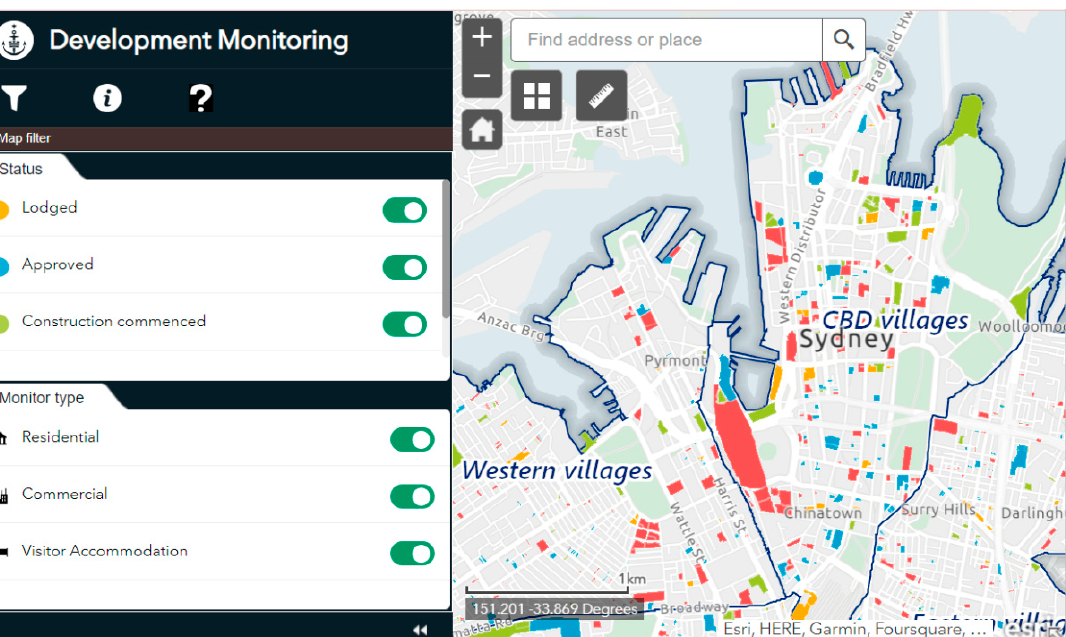
Figure 5. Snapshot of Development Monitoring interactive map (https://cityofsydney.maps.arcgis.com/apps/webappviewer/index.html?id=ab67ecb8c37f4ae38ac77066e02b03fe, accessed on 3 May 2021).